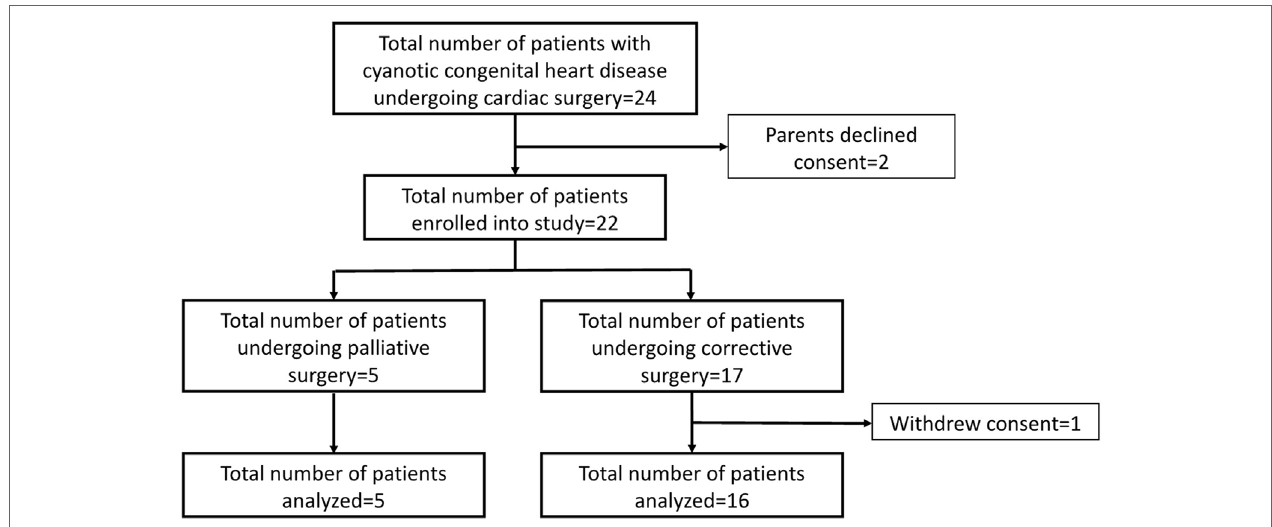
FigUre 1 | CONSORT